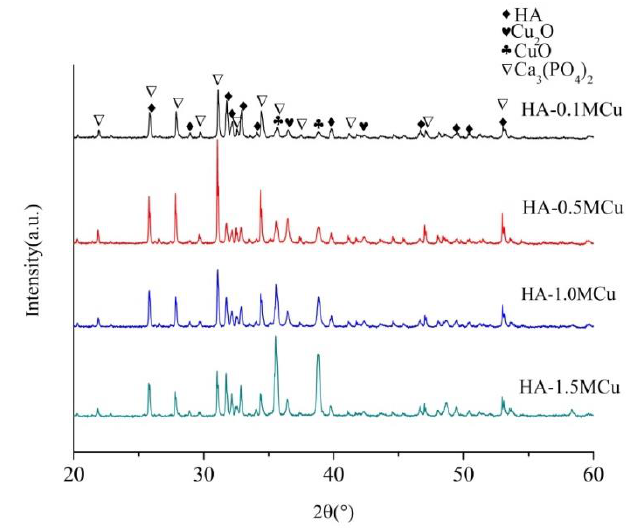
Figure 5. XRD patterns of Cu-doped HA macrobeads after sintering.